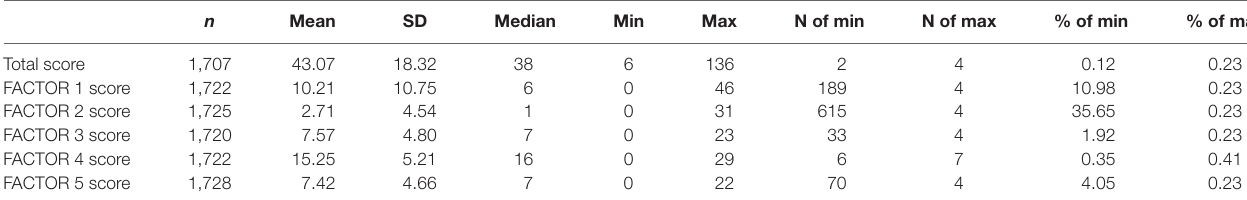
disorder. The area under the curve was > 0.8. Table 7 depicts the calculation of the cut-off points of the total score for the EPYFEI scale according to the different levels of sensitivity and